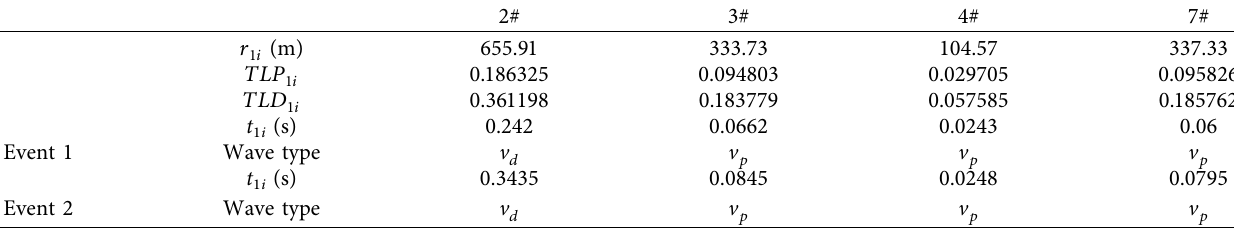
Figure 10: Planar graph showing the arrangement of the monitoring points during the field tests. Table 4: Correction of velocity type of first arrival